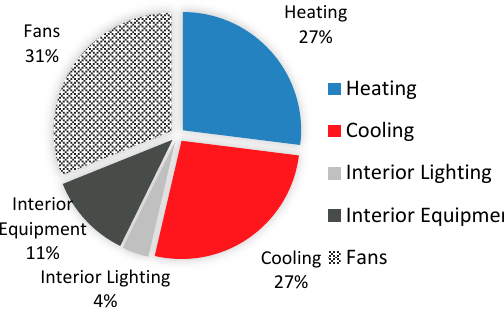
Figure 8. Energy consumption of various equipment.